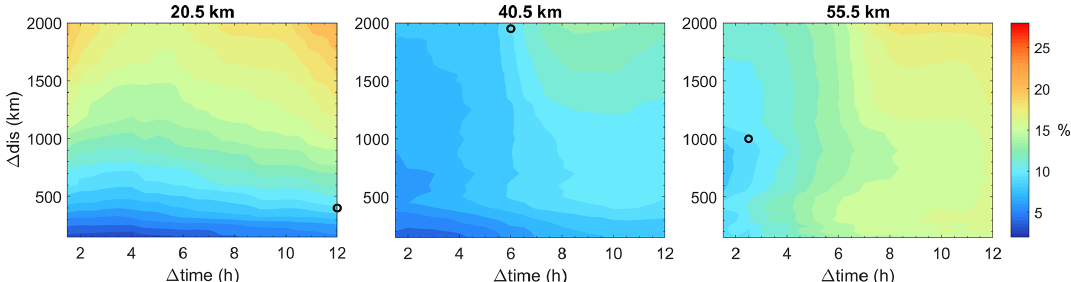
Figure 4. Ensemble mean geophysical variability (2 σ ) between ACE-FTS and OSIRIS O 3 , as estimated from CMAM, EMAC, and WACCM data. Calculations performed for time difference criteria of within 1.5 to 12h in 0.5h increments and distance difference criteria of within 150 to 2000km in 50km increments. Black circles indicate the coincidence criteria optimized for the greatest number of coincident profiles with geophysical variability limited to 10%.